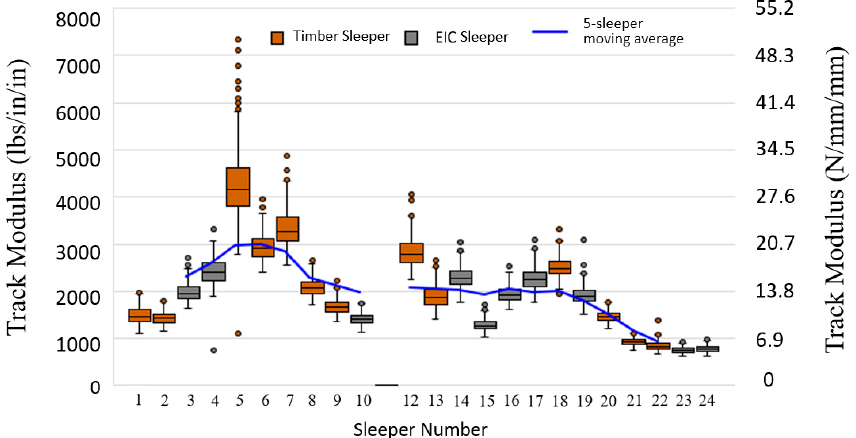
Figure 13. The track modulus results for each individual sleeper instrumented in the field test zone.